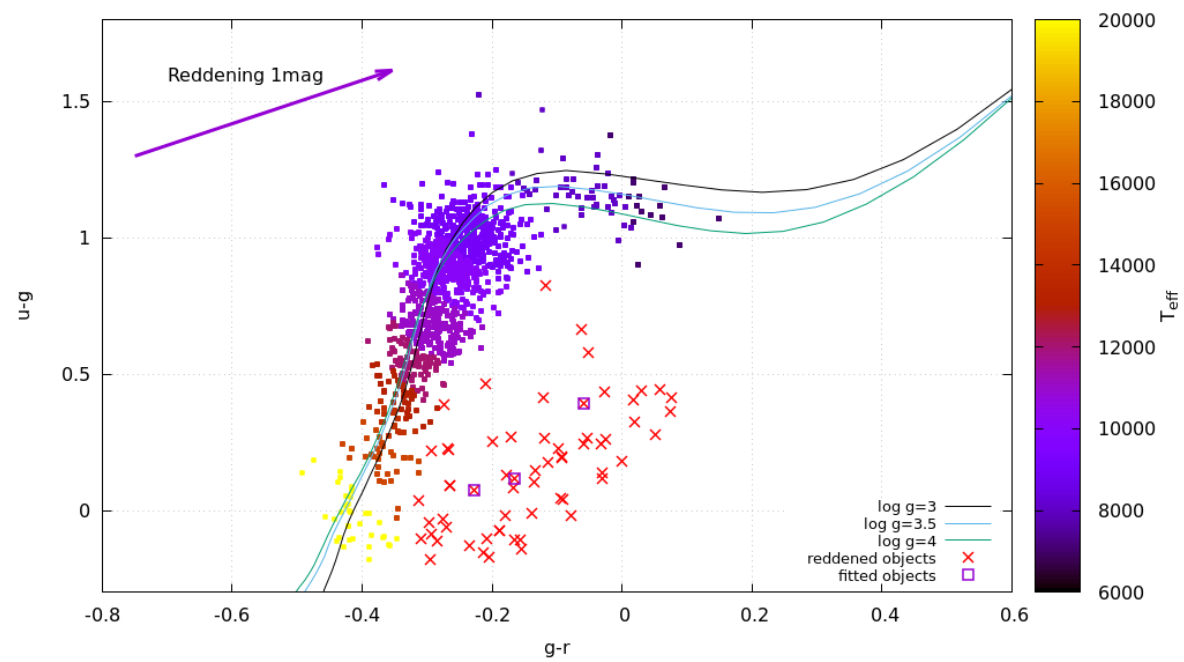
Figure 1. Color-color diagram of a hot star sample, over-plotted with lines of constant log g according to Castelli & Kurucz (2004). The sam- ple is divided ’by eye’ into different temperatures. The reddening vector corresponds to a reddening of 1 mag due to interstellar extinction, according to Kim & Lee (2007). Objects marked as red asterisks seemingly show strong reddening, but interstellar extinction is unlikely to be the cause of the red excess. Visual inspection of their spectra revealed that most of them have a cool companion. Objects marked with squares were fitted using our new code. Plot adapted from Kreuzer (2013).